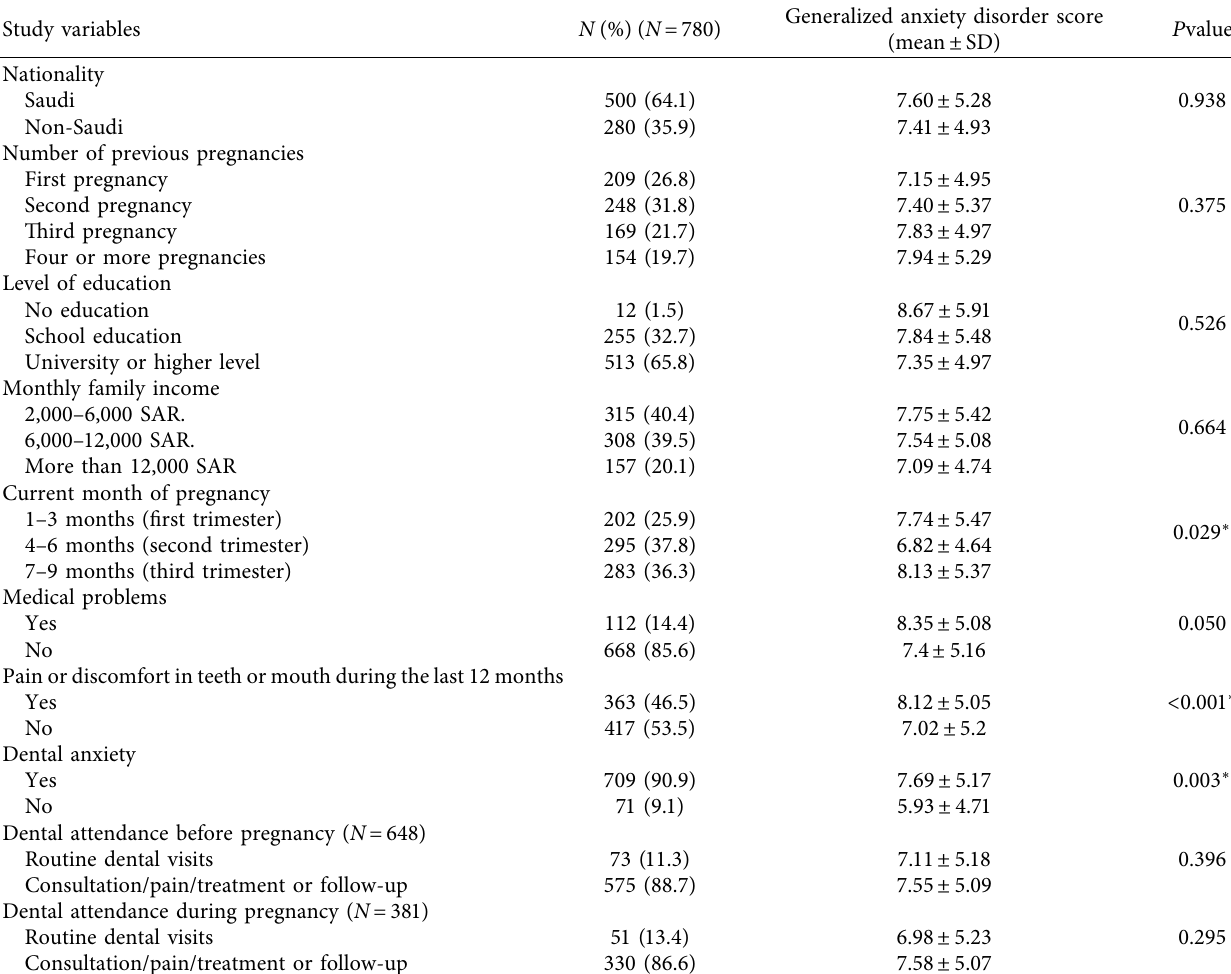
Table 1: Distribution of sociodemographic factors and their relationship with generalized anxiety disorder in pregnant women. Study variables